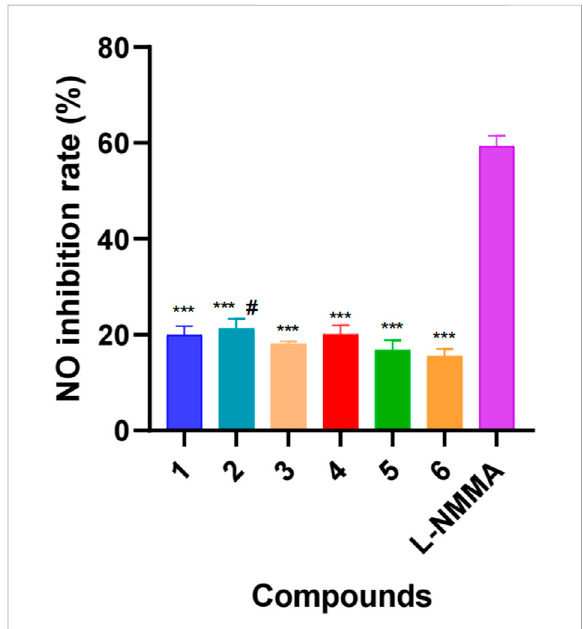
FIGURE 4 Inhibitory effects of six new new diterpenoid alkaloids on NO production in LPS-induced RAW264.7 cells. L-NMMA: L-NMMA was used as positive control. Error bars indicate SD, #, p < 0.05 vs. compound 6 , ***, p < 0.001 vs.